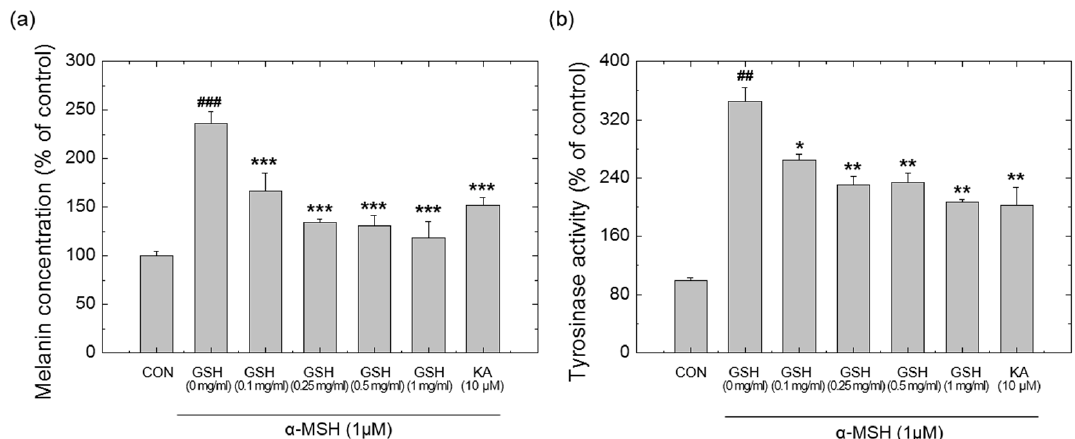
Figure 3. ( a ) Inhibitory e ff ects of GSH and α -MSH on melanin production in B16F10 cells. ( b ) Inhibitory e ff ects of GSH and α -MSH on tyrosinase activity. Kojic acid (KA) was used as a positive control. Each value represents the mean ± standard deviation (SD) from triplicate experiments. (##, ###, p < 0.01, 0.001, respectively. significant versus vehicle-treated; *, **, *** p < 0.05, 0.01, 0.001, respectively. significant versus α -MSH alone).